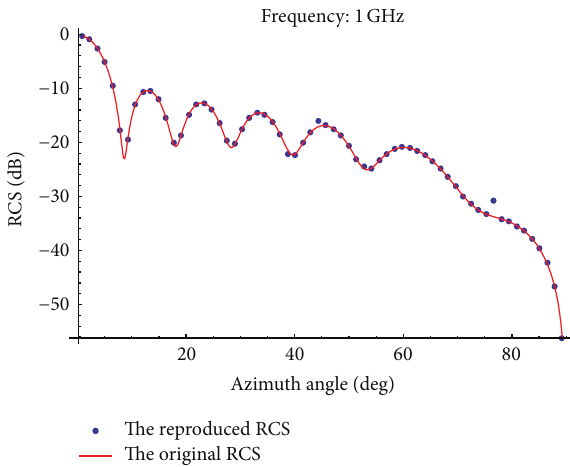
Figure 15: Backscattered RCS for a perfectly conducting triangular flat plate, 𝑘 = 6 and 𝜑 = 60 ∘ .